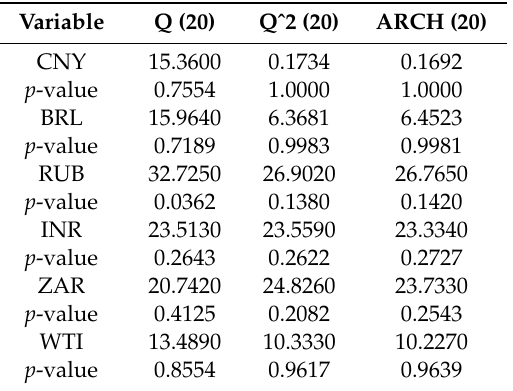
Table A2. Ljung-Box test and Lagrange Multiplier test.